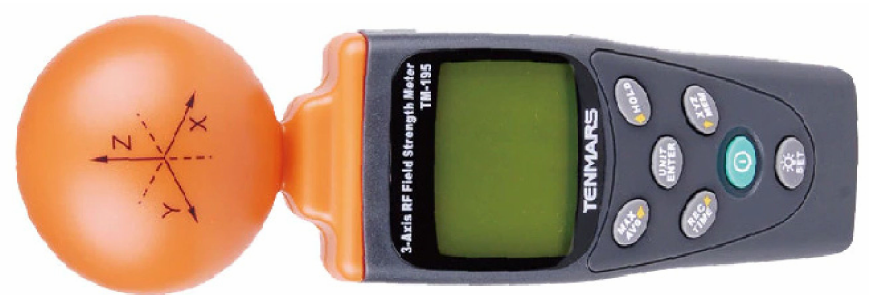
Figure 2. The TENMARS TM-195 3-axis RF field strength meter electromagnetic field radiation (EMF)